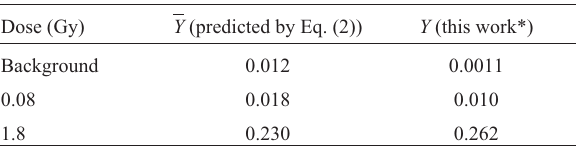
Table 4 - Comparison between the values expected by Eq. (2) and the frequency of micronuclei obtained in this research, considering partial-body